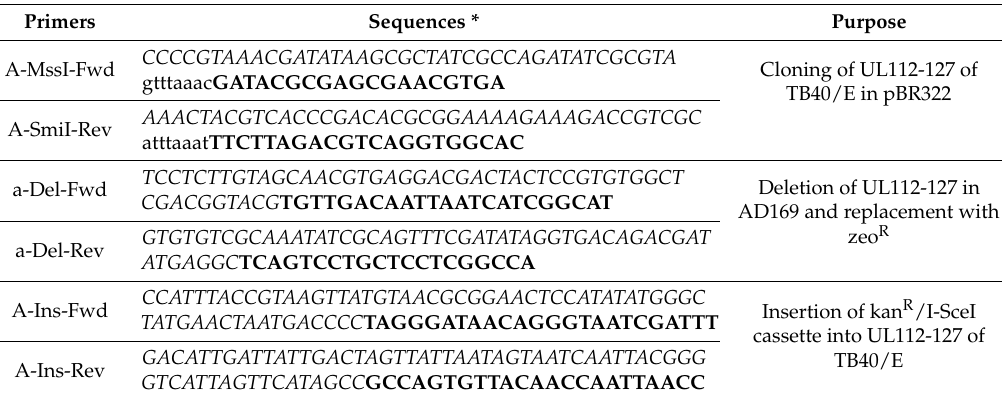
Table 1. Primers used to transfer TB40/E fragment ‘A’ to